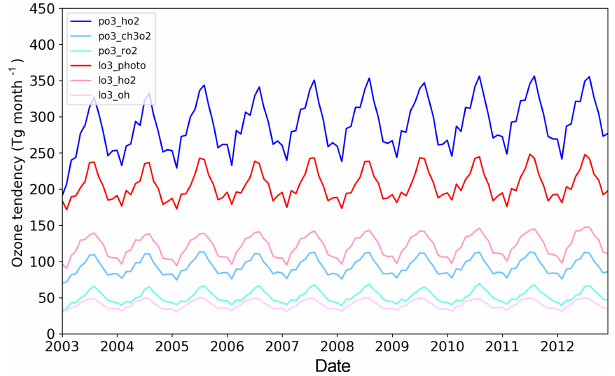
Figure 12. Decadal variation in the major tropospheric ozone chem- ical production and loss terms from the ECHAM-HAMMOZ refer- ence simulation. Blueish colors represent the global ozone produc- tion rates (in Tgmonth − 1 ) due to the reaction of HO 2 , CH 3 O 2 , and other organic peroxy radicals (RO 2 ); reddish colors show ozone loss rates due to the photolysis and subsequent reaction of O ( 1 D ) with water, due to the reaction of ozone with HO 2 , and due to reaction with